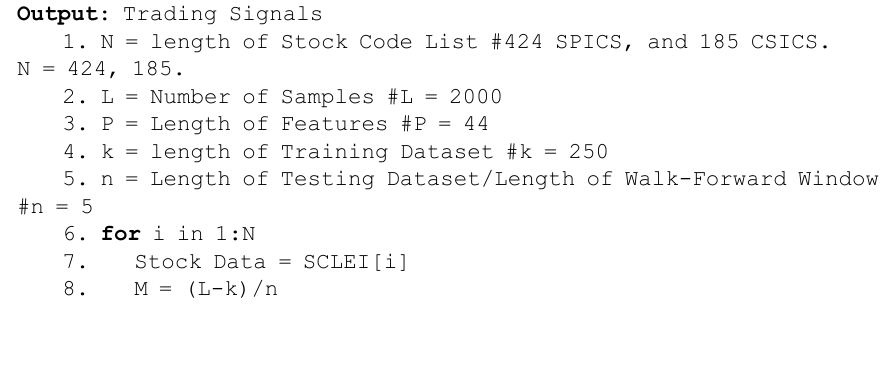
Algorithm 1. Generating Trading Signals in R Language